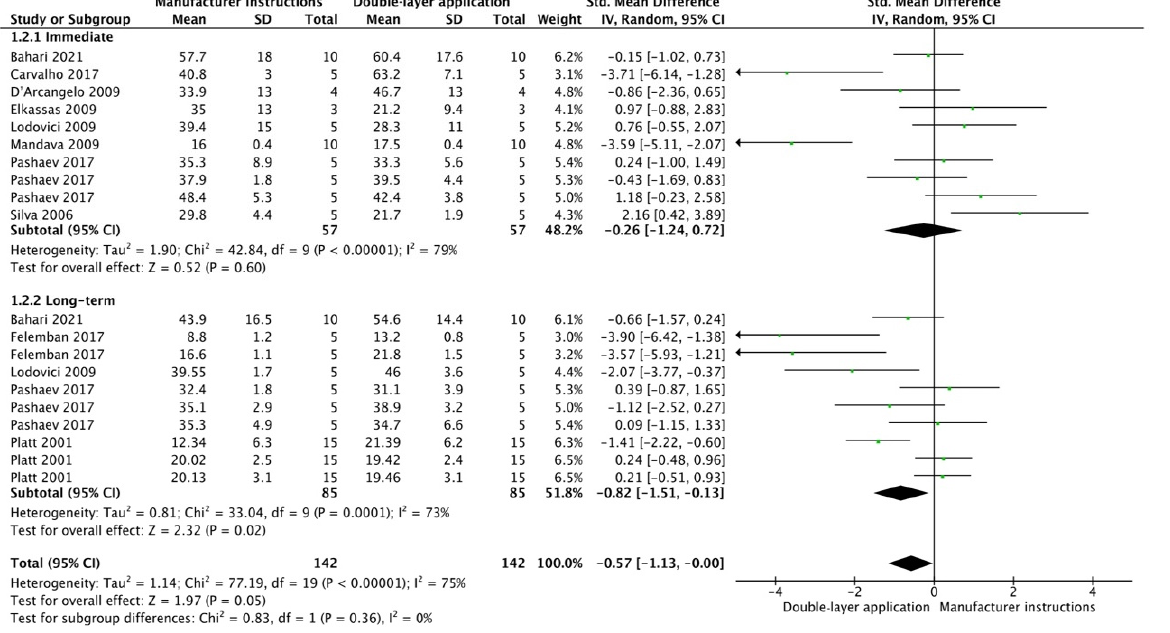
Figure 4. Forest plot showing the bond strength values when the adhesive was applied in two consecutive layers [63,69,72–79].